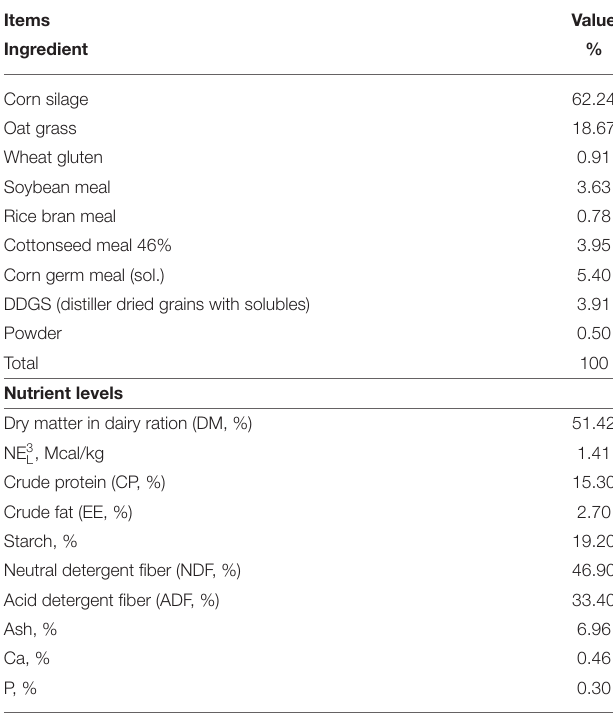
TABLE 2 | Ingredients and chemical composition of dietary treatments of post-perinatal period dairy